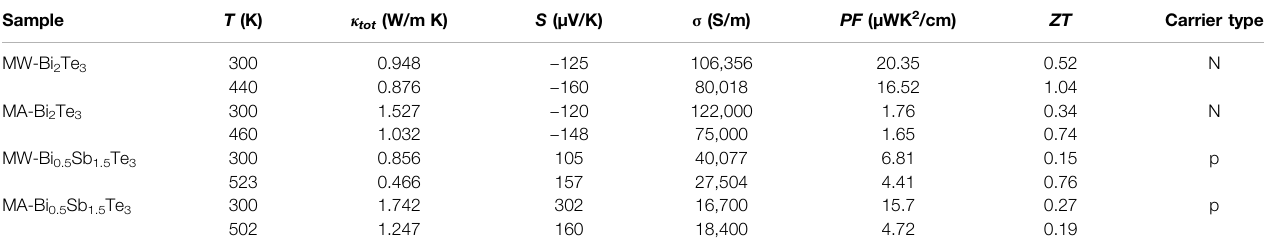
TABLE 2 | Transport properties for MW- and MA-Bi 2 − x Sb x Te 3 samples: total thermal conductivity ( κ tot ), Seebeck coef fi cient ( S ), electrical conductivity ( σ ), power factor ( PF ), and TE fi gure of merit ( ZT ) at given temperature ( T ) values. The rightmost column speci fi es the carrier type. Sample T (K) κ tot (W/m K)